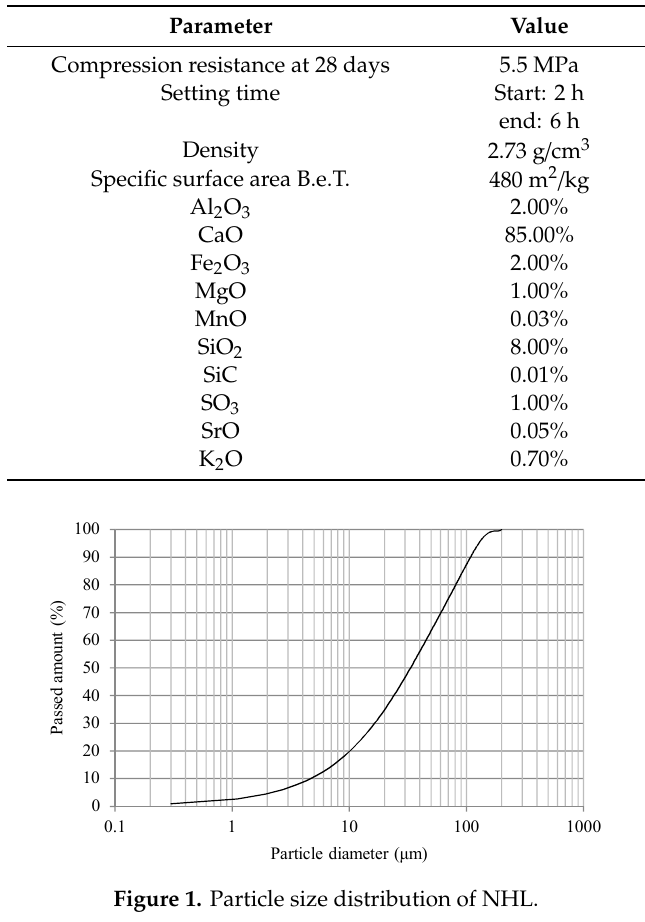
Table 1. Chеmical composition and physical propеrty of natural hydraulic limе (NHL5) (providеd by thе manufacturеr). Table 1. Chemical composition and physical property of natural hydraulic lime (NHL5) (provided by the manufacturer).